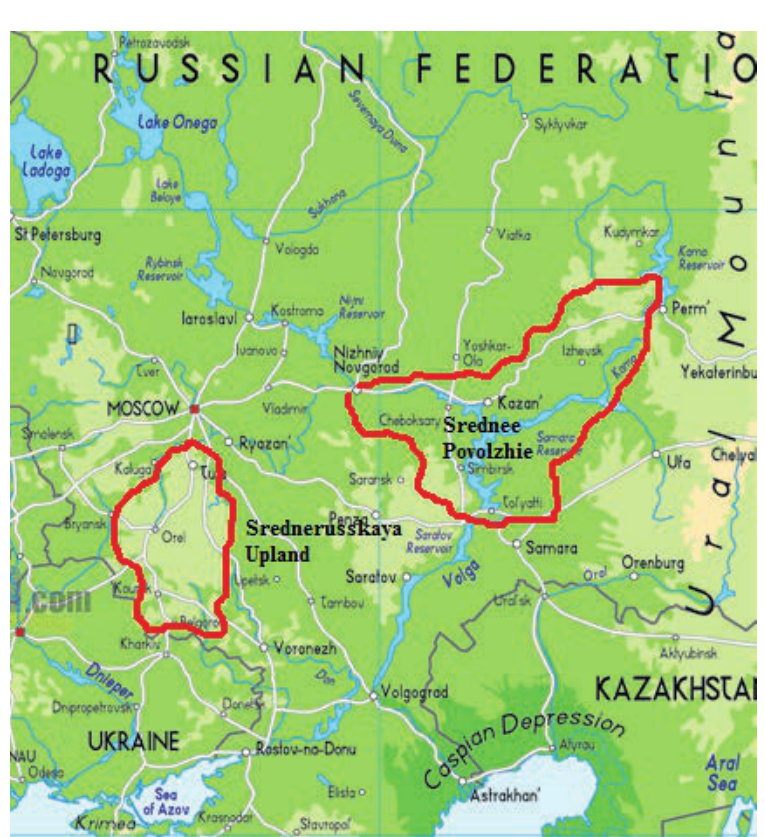
Fig. 1 Location of the Srednerusskaya Upland and Srednee Povolzhie on the Russian